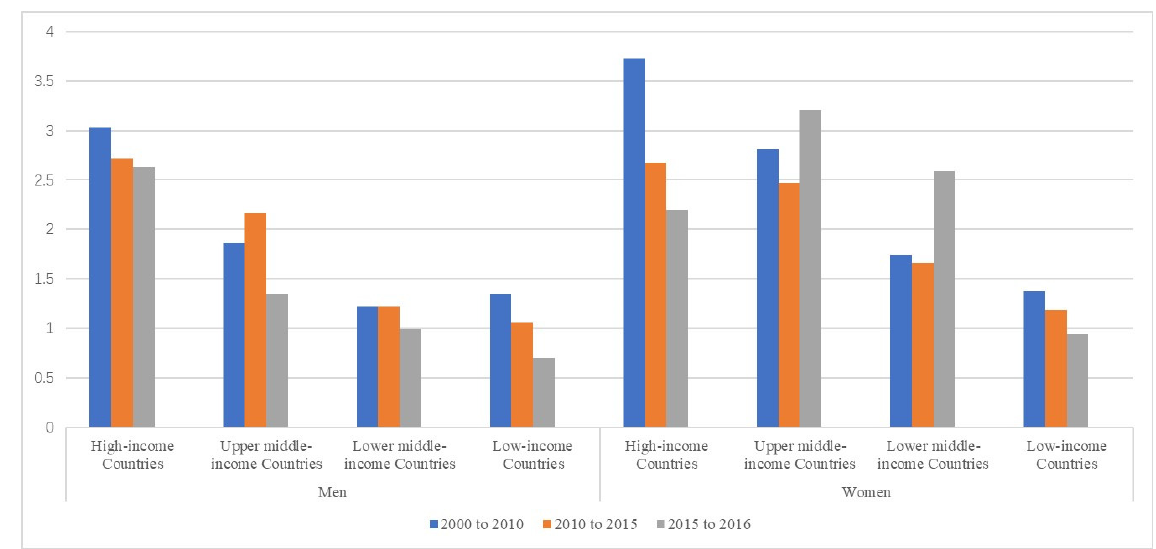
Figure 1. Percentage (%) of decline from 2000 to 2016 in premature CVD-related death rates, in men and women, by national income group.